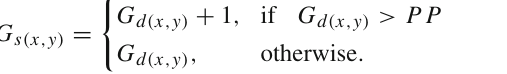
Extraction algorithm for f i ( B